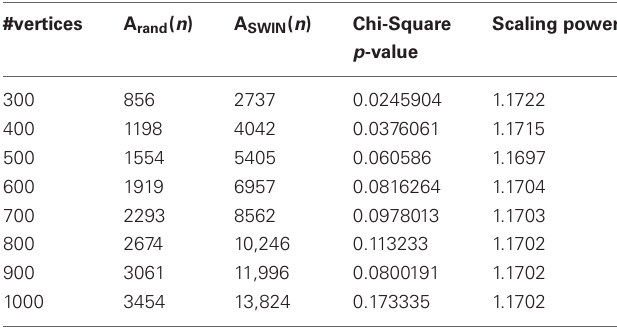
Table 1 | Anchor points for random graphs and small-world